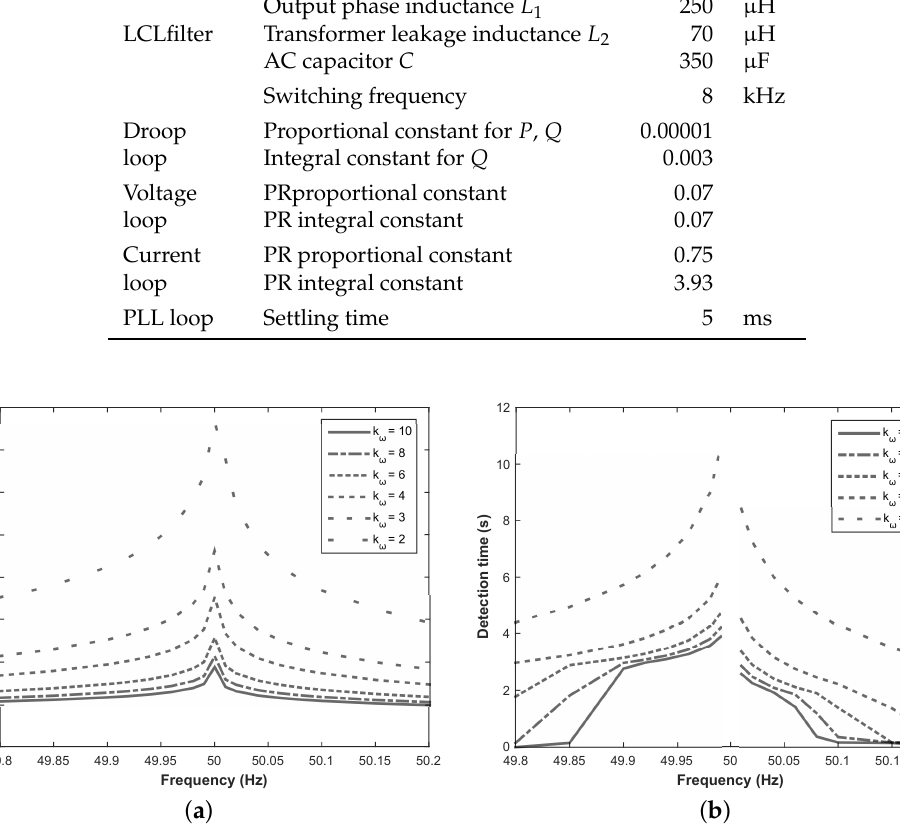
Figure 7. SFS detection times applied to CC-VSI and VC-VSI. ( a ) Operating with a grid supply inverter (GSI) (CC-VSI). ( b ) Operating with a grid support and constitution inverter (GSCI)